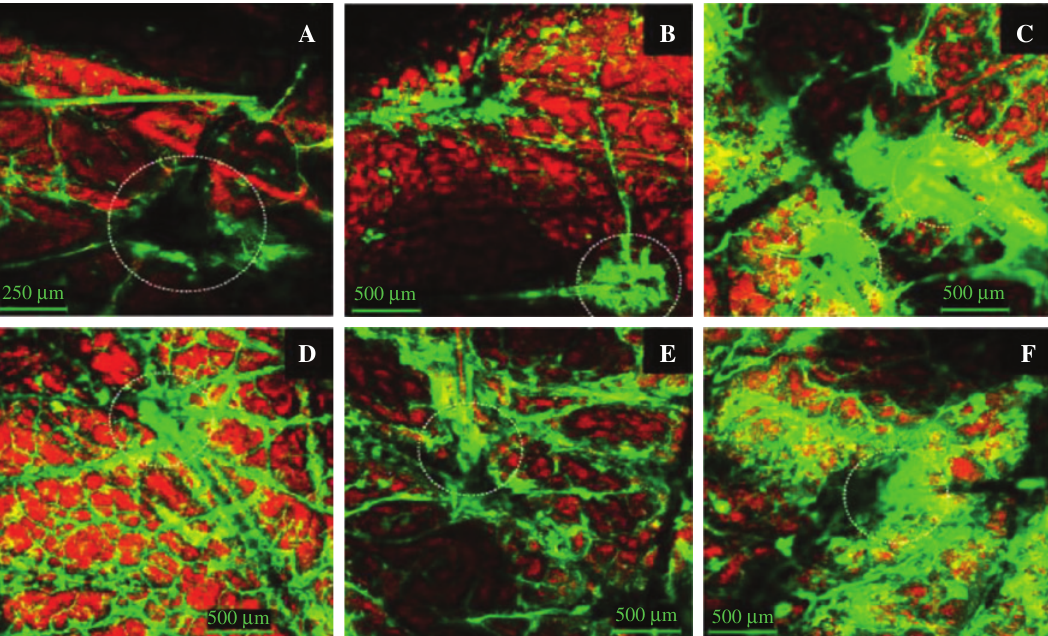
Figure 8: x - y images showing follicular localization of fluorescent NPs after application of F-NP (20 nm) for (A) 30 min, (B) 1 h, and (C) 2 h and of F-NP (200 nm) for (D) 30 min, (E) 1 h, and (F) 2 h. The white circles correspond to hair follicles. Note that, in panels A, B, and C, the levels of green fluorescence are concentrated in the follicular regions, and in panels D, E, and F, time-dependent NP accumulation in hair follicles is observed. Reprinted from Rossi et al. [77].